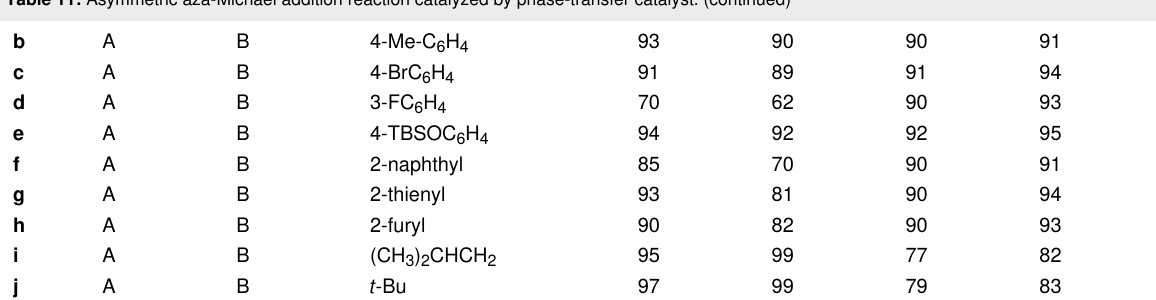
Table 12: Asymmetric aza-Michael/alkylation reaction catalyzed by cinchona alkaloid-derived quaternary ammonium salts.